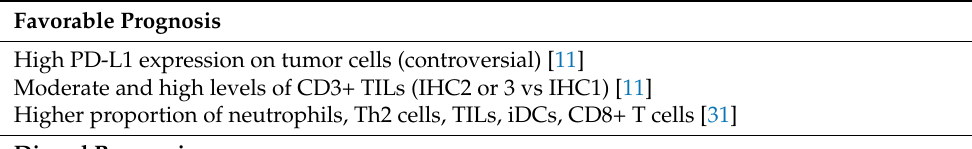
Figure 1. The main elements of the TME and their interaction. Table 1. Elements of the tumor microenvironment of thymic epithelial tumors associated with favorable and dismal